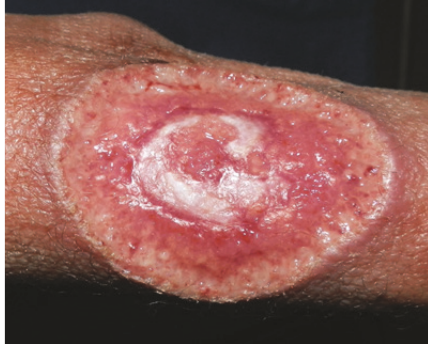
Figure 2: Ulcer on forearm before Penicillin G treatment.